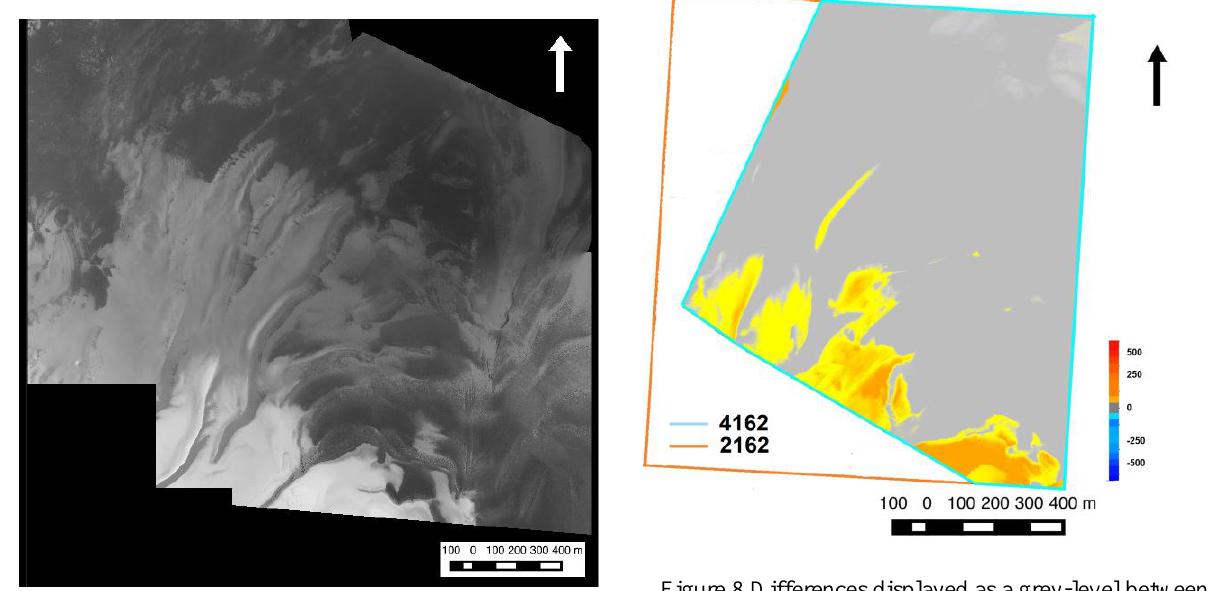
Figure 7 Overlapping areas of H2162_0000,